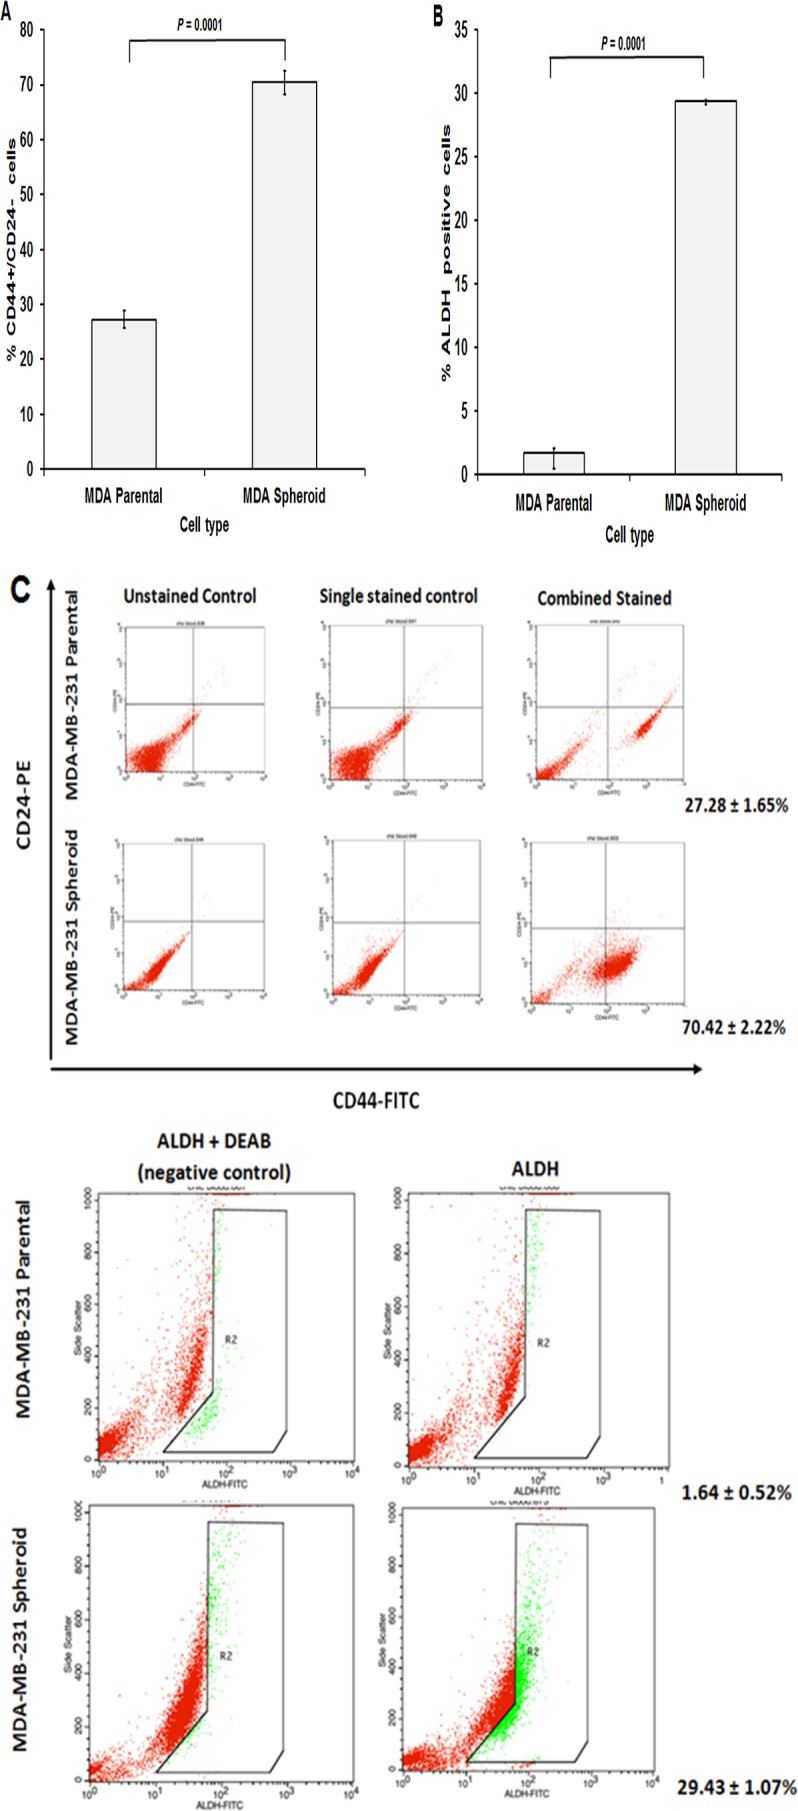
Cancer stem cells surface markers and ALDH activity of MDA-MB-231 spheroids assessed by flow cytometry analysis.(A) Spheroid cells exhibited a significantly higher percentage of CD44+/CD24− cells populations (70.42 ± 2.22%) compared to that of the parental cells (27.28 ± 1.65%). (B) ALDH activity also exhibited an increased in spheroid cells with 29.43 ± 1.07% compared to parental cells 1.64 ± 0.52%. (C) Representative flow cytometric dot plots were shown whereby R2 is the region of ALDH-positive cells.